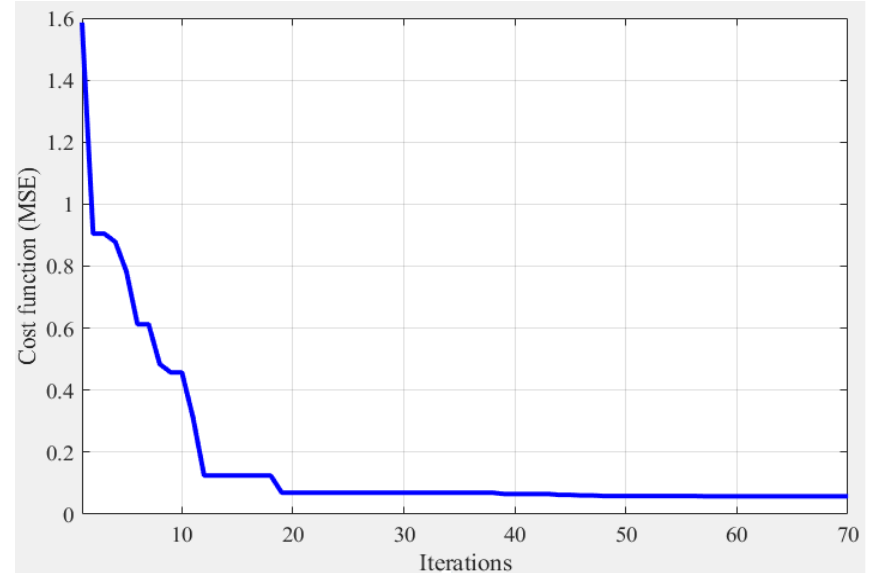
Figure 16. Cost function variation during the optimization process.